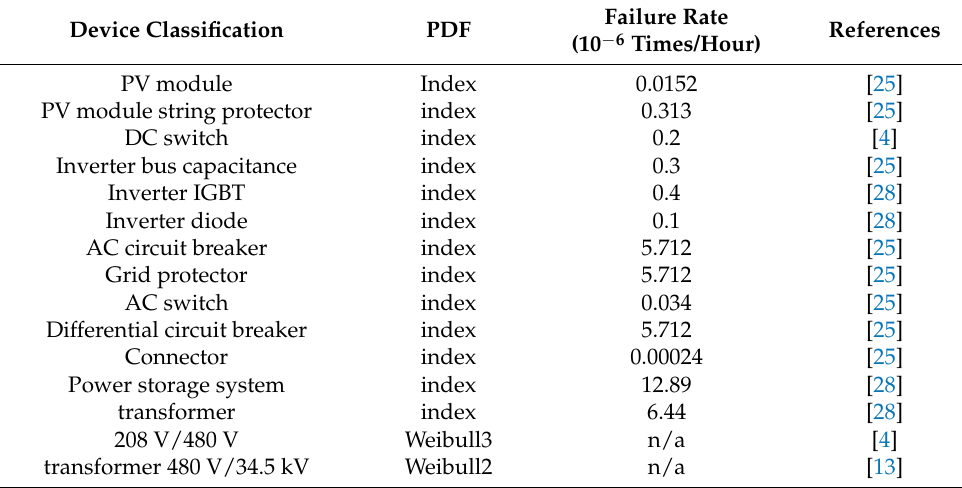
Table 2. Failure rate and obeying probability density function of each component of the grid- connected PV power